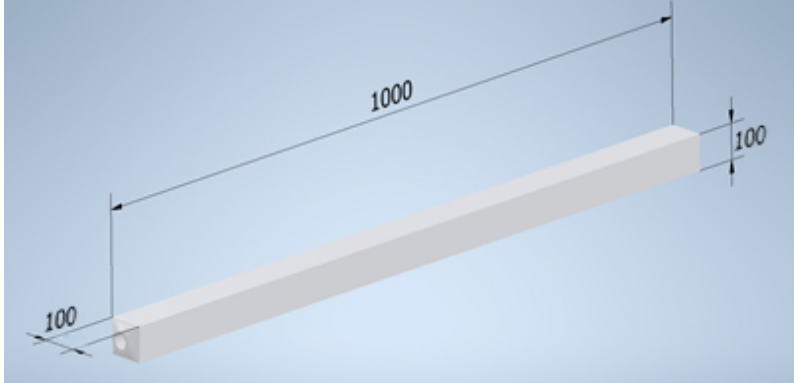
Figure 3. Concept of concrete block and block dimensions [mm].